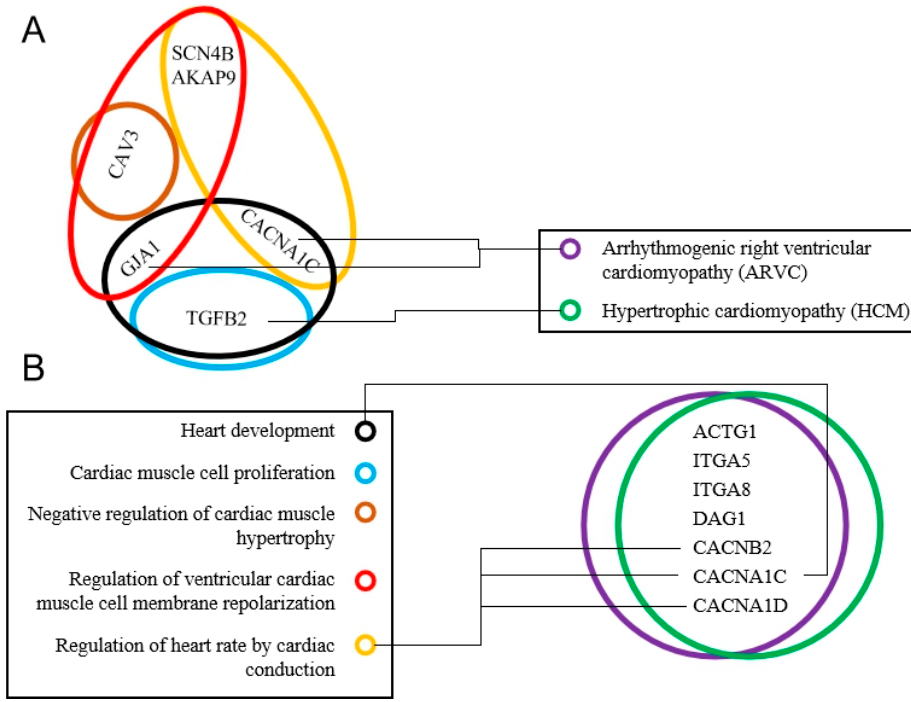
Figure 5. Heart-related signaling pathways. ( A ) Repeated genes in different heart-related biological processes in heart-related signaling pathways. ( B ) Repeated genes in different cardiac-related signaling pathways in cardiac-related biological processes. The same color on the left side of ( A ) and ( B ) represents the same signaling pathways; the same color on the right side of ( A ) and ( B ) represents the same biological processes.